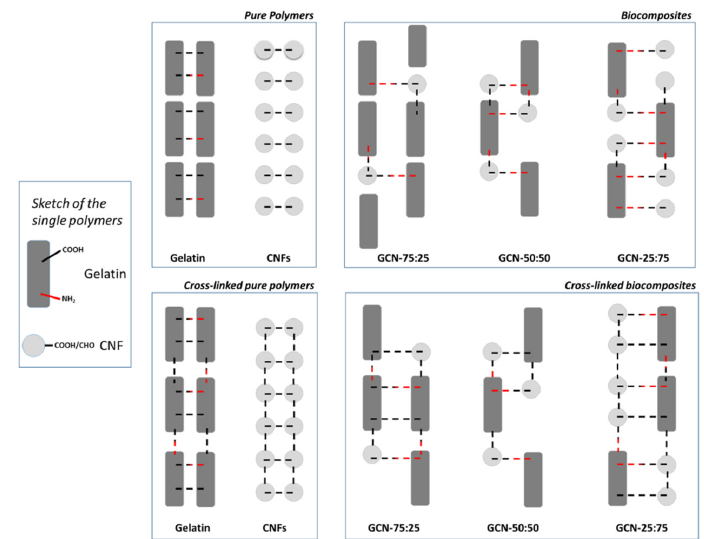
(top scheme) and cross-linking process (down scheme). Note that the condensation reactions can occur between carboxylic groups (black bonds in Gel and CNFs), carbonyl groups (black bonds in CNFs) and amino groups (red bonds in